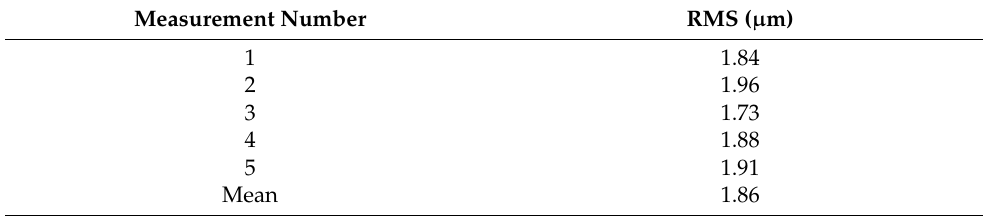
Figure 11. The measurement results: ( a ) The measured surface shape, ( b ) the measurement error. Table 5. The results of repeated measurement of the standard ball.